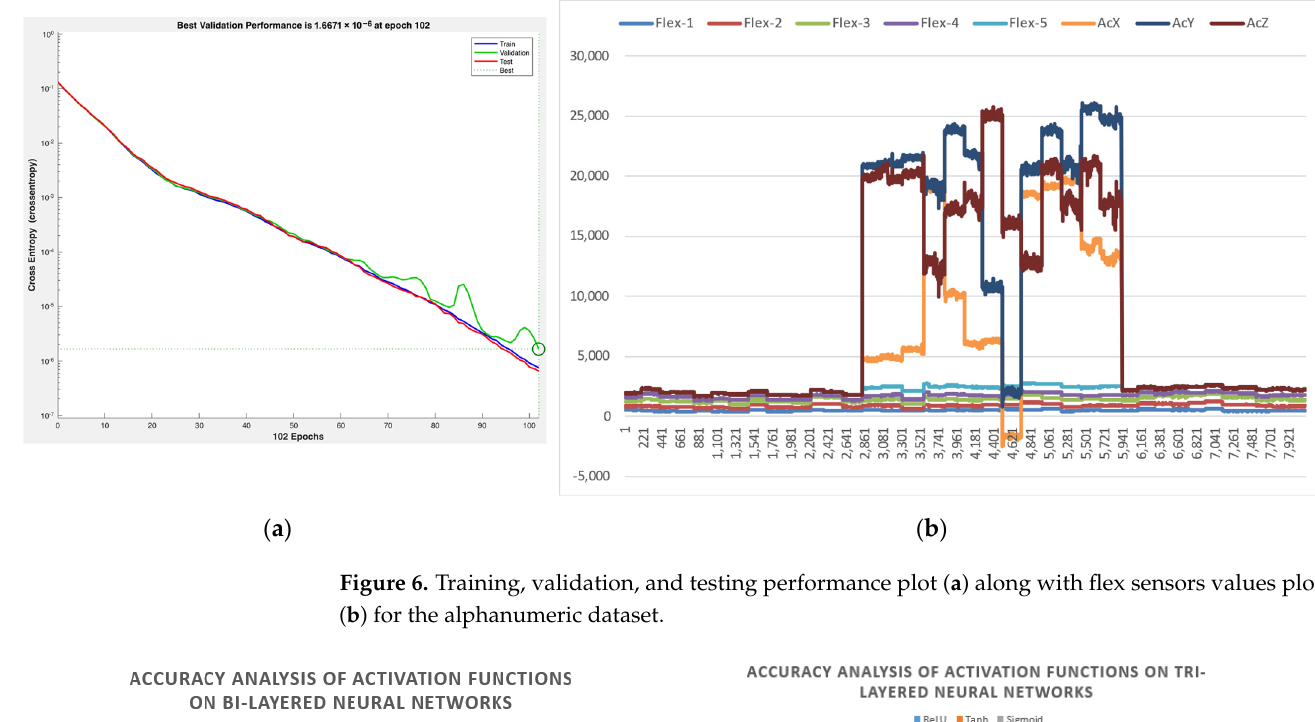
Figure 6. Training, validation, and testing performance plot (on left) along with fl ex sensors values plot (on right) for the alphanumeric dataset.